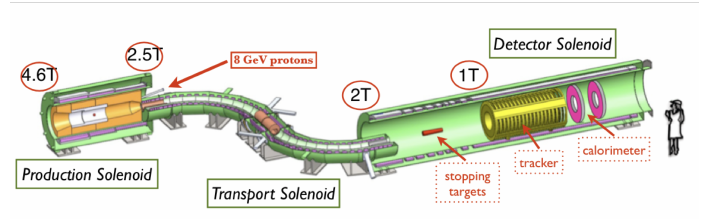
Figure 18. Schematic of the Mu2e